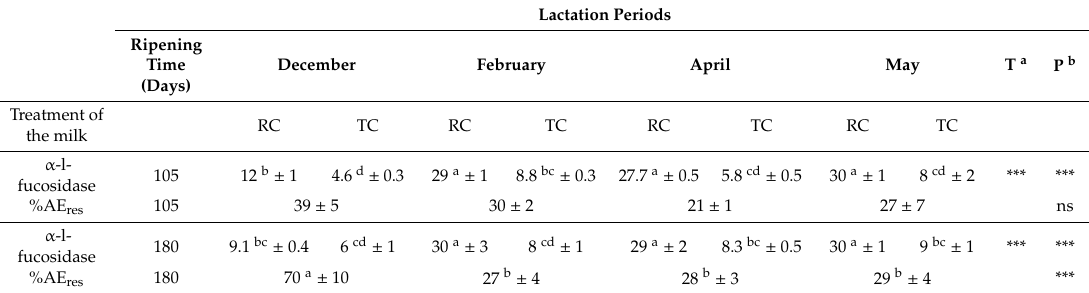
Table 5. α -l-Fucosidase activity (Uh − 1 g DM − 1 ) in Fiore Sardo obtained from raw (RC) or thermized milk (TC) as a function of lactation periods and ripening